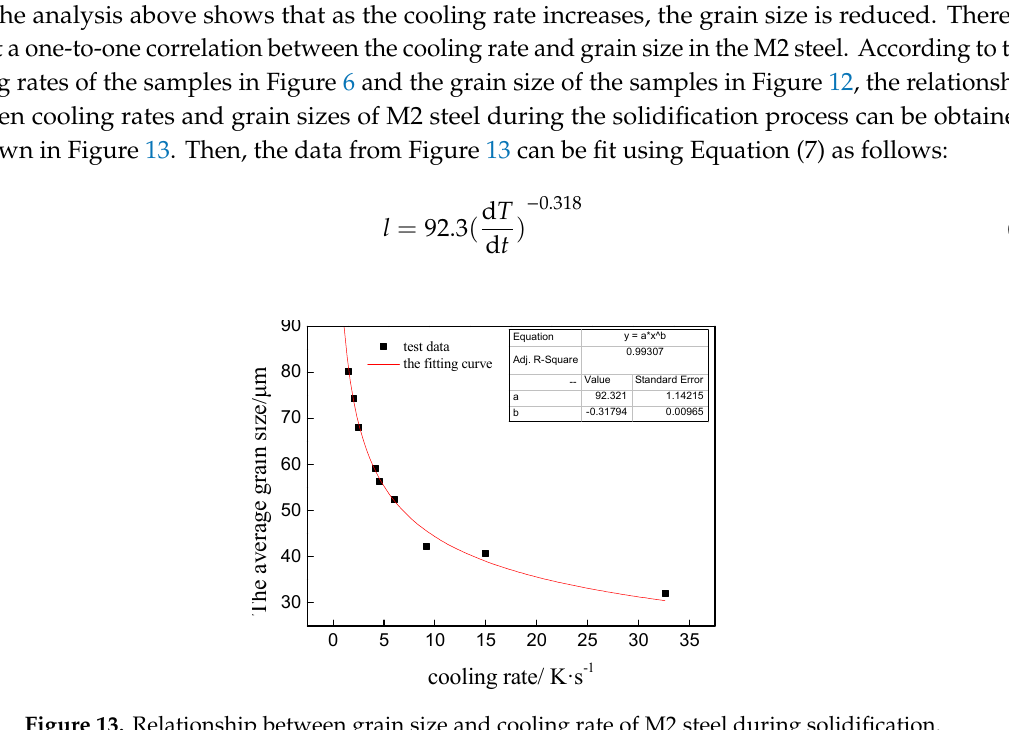
Figure 13. Relationship between grain size and cooling rate of M2 steel during solidification.